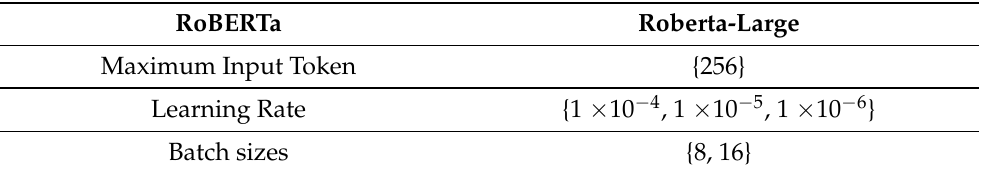
Table 6. Experimental setup for hyperparameter tuning.